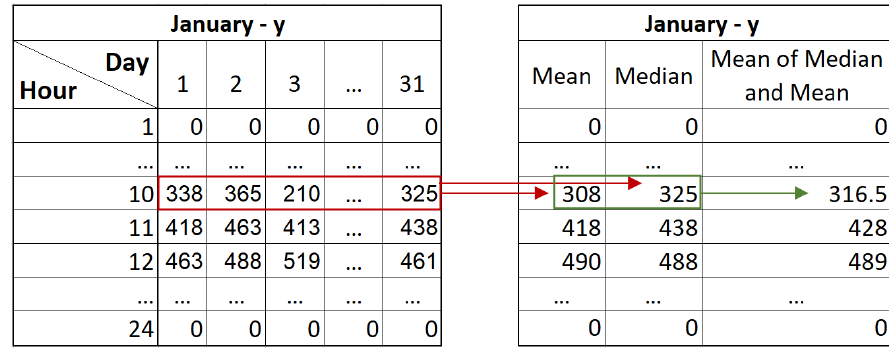
The seasonal adaptation adjusted the values according to the month of the year by increasing/decreasing every predicted value that was on average lower/higher than the target values of the same hour of the day of that month in past years. The seasonal adaptation (SA) is calculated as follows: